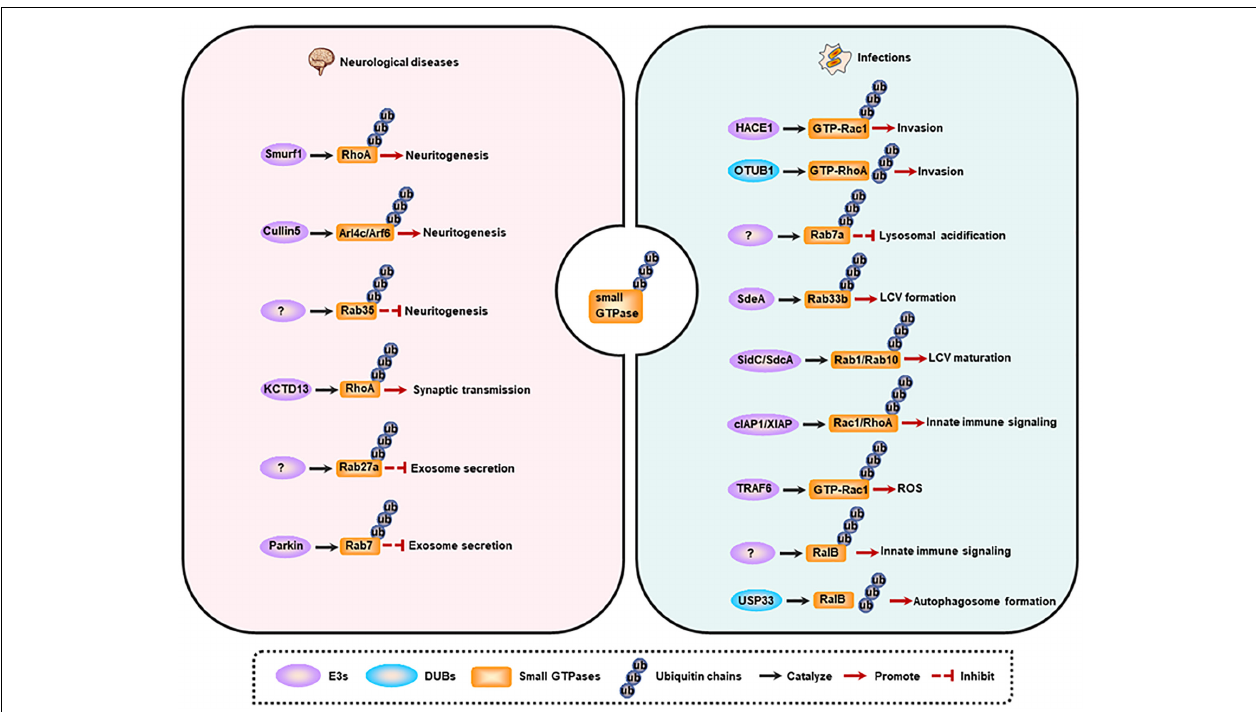
FIGURE 3 | Small GTPase ubiquitination and membrane trafficking-related diseases. Left, small GTPase ubiquitination is involved in neuritogenesis, synaptic transmission, and exosome secretion. Dysregulation of these processes contributes to the occurrence of neurological diseases. Right, small GTPase ubiquitination regulates pathogen invasion, lysosomal acidification, LCV maturation, innate immune signaling activation, ROS production, and autophagy induction. Dysregulation of these processes contributes to the occurrence of infections. LCV, Legionella- containing vacuole; ROS, reactive oxygen